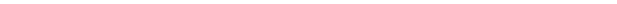
Fig. 2 Soluble (non-MT) tubulin activates processive motility of HSET on single MTs. a Schematic. EGFP-HSET truncations were diluted in P12 buffer and monitored on GMPCPP-stabilized MTs by time-lapse